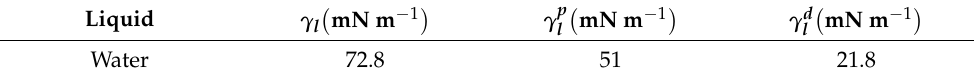
Table 7. Surface energy of liquids with polar and dispersion surface energy